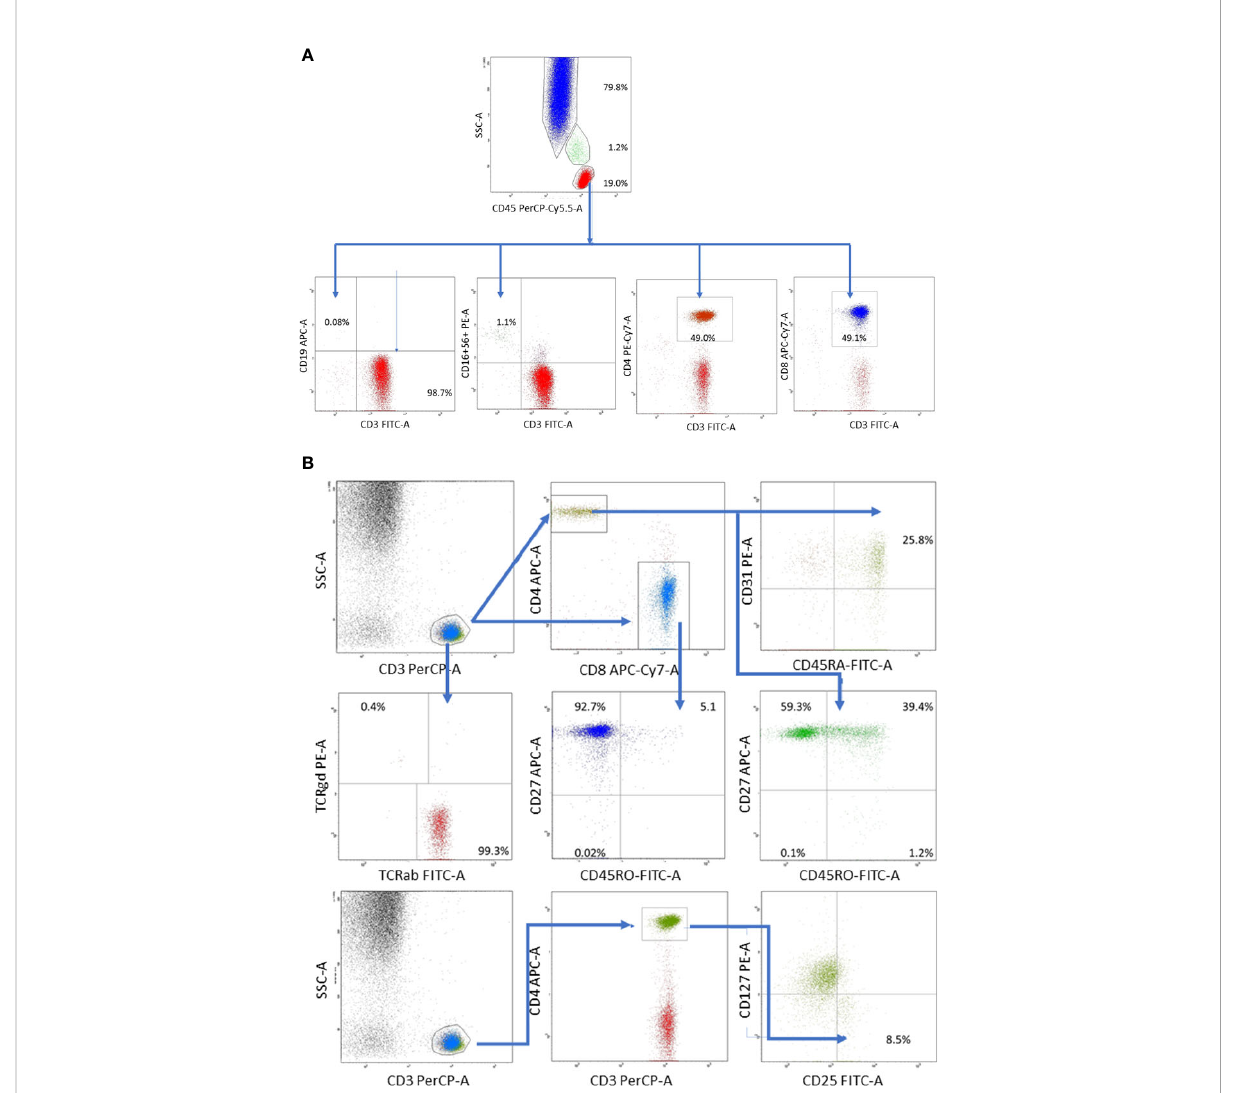
FIGURE 2 (A) Distribution of whole blood leukocyte subsets was based on differential expression of CD45 and side scatter characteristics: lymphocytes (low scatter and high CD45 expression), monocytes (medium side scatter and CD45 expression), and polymorphonuclears (high scatter and low CD45 expression) composed 19.0, 1.2% and CD79.8% of whole blood leukocytes, respectively. T lymphocytes were de fi ned as CD3+CD19- cells, B lymphocytes as CD19+CD3- cells and composed 98.7% and 0.08% of total lymphocyte population, respectively. NK cells de fi ned